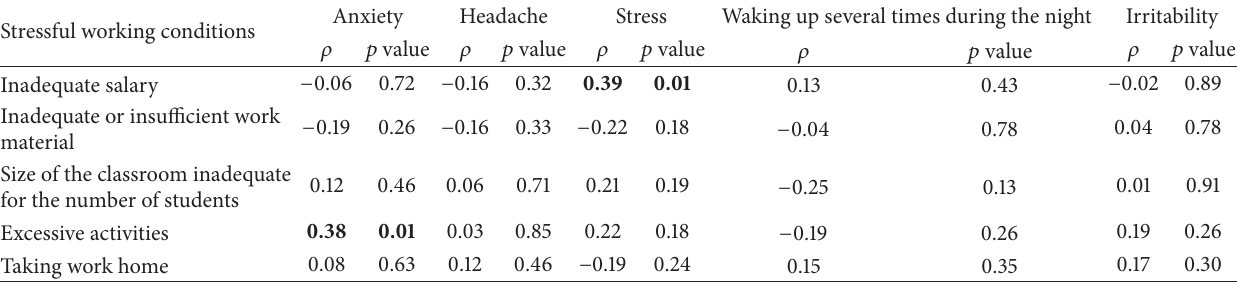
Table 4: Correlation between the main self-reported working conditions and biopsychosocial consequences for the health of teachers. Stressful working conditions